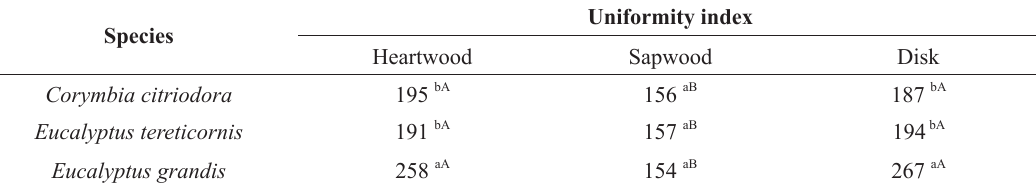
Uniformity index of heartwood and sapwood regions and of the entire